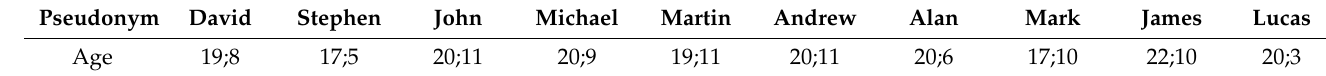
Table 1. Pseudonyms and ages of participants ( n =